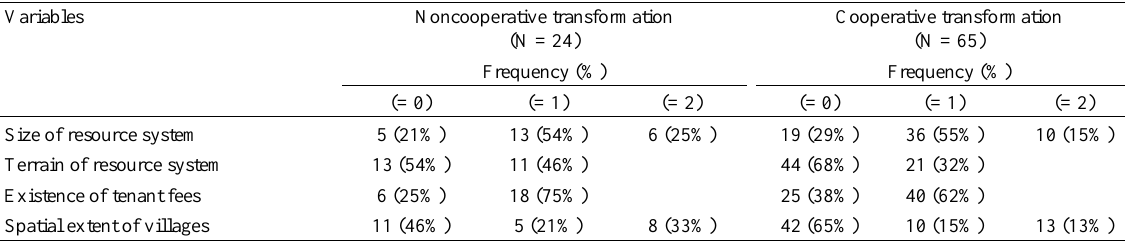
Table 2. Categorical variable statistics by cooperative and noncooperative transformations. For details, see Table 1.